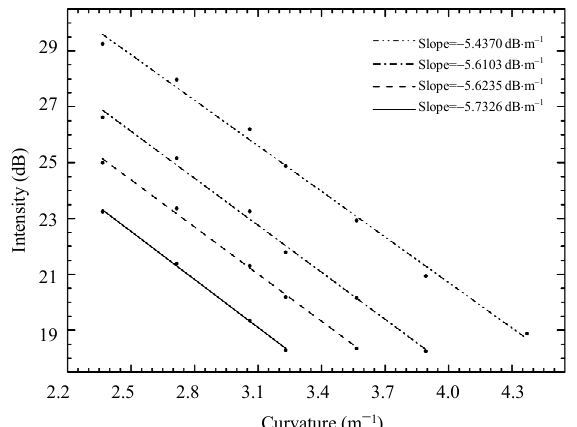
Fig. 4 Sensitivities obtained in the OTDR along the distance measurements.